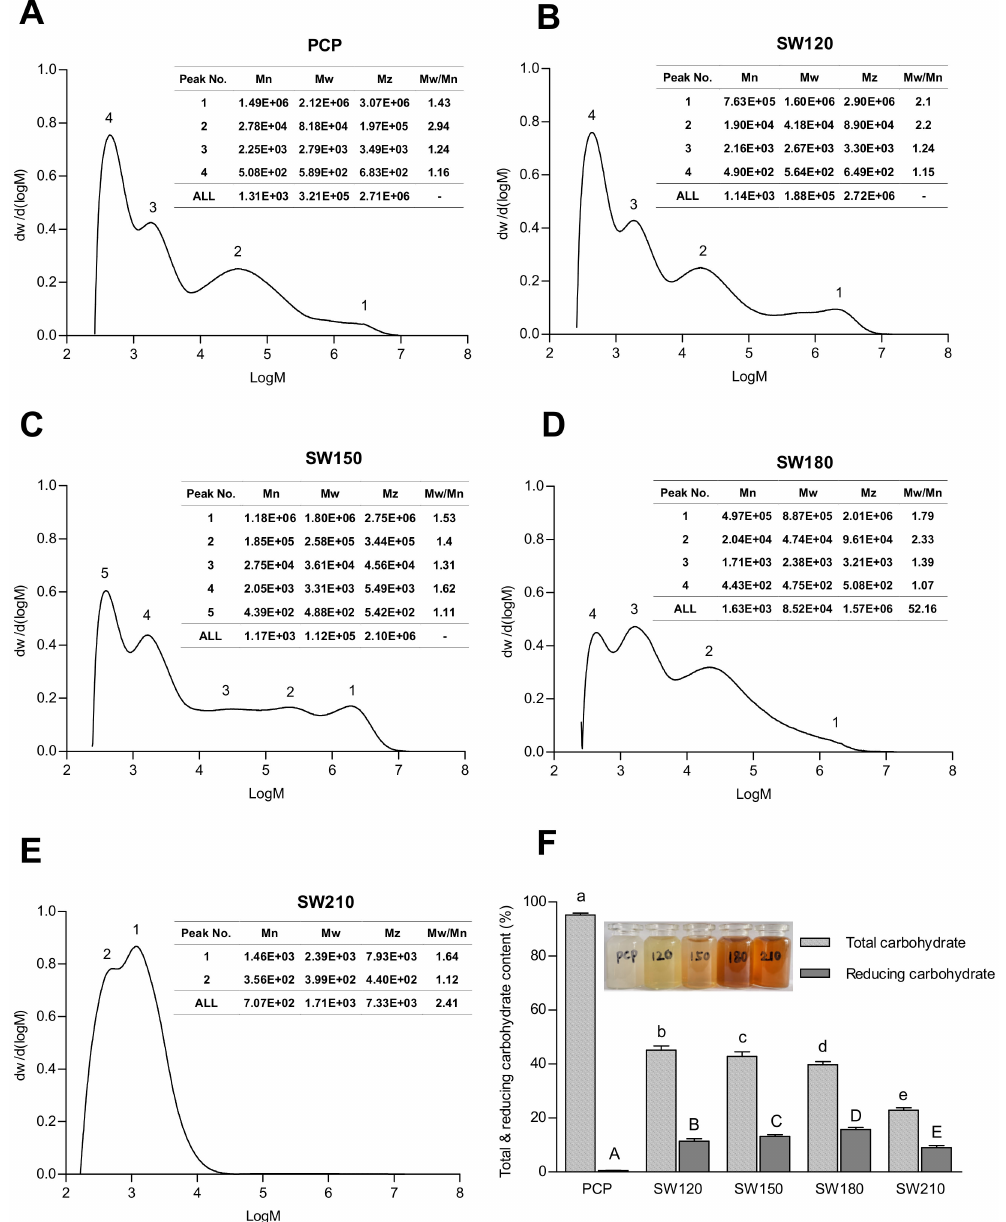
Figure 1. The molecular mass distribution of PCP ( A ), SW120 ( B ), SW150 ( C ), SW180 ( D ), SW210 ( E ), and total carbohydrate and reducing carbohydrate ( F ) of polysaccharides under different subcritical water conditions. Data were expressed by means ± standard deviations ( n = 3). Values with different letters are significantly different ( p < 0.05). PCP, pumpkin crude polysaccharides; SW120, PCP under subcritical water 120 ◦ C treatment; SW150, PCP under subcritical water 150 ◦ C treatment; SW180, PCP under subcritical water 180 ◦ C treatment; SW210, PCP under subcritical water 210 ◦ C